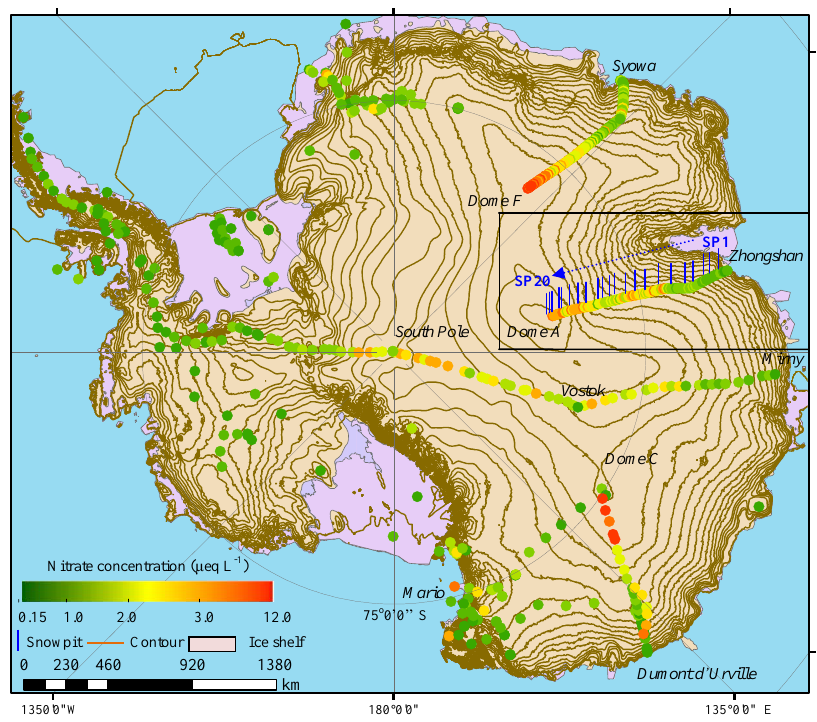
Figure 2. Concentrations of NO 3- in surface snow across Antarctica. Note that the values of crystal ice around Dome A were not included. The data of DDU to Dome C is from Frey et al. (2009). The other surface snow NO 3- concentrations are from compiled data (Bertler et al., 2005)and references therein). Also illustrated are the locations of snowpits on the traverse route from Zhongshan to Dome A in this study (SP1 to SP20, solid short blue line; Table 1).